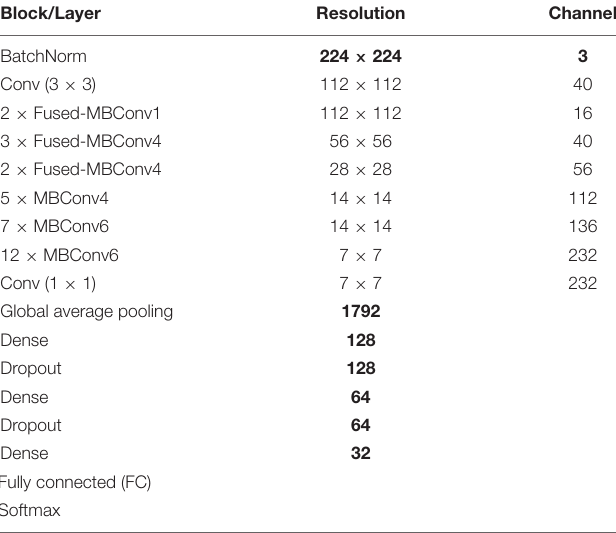
TABLE 1 | Details of blocks and layers used in the proposed